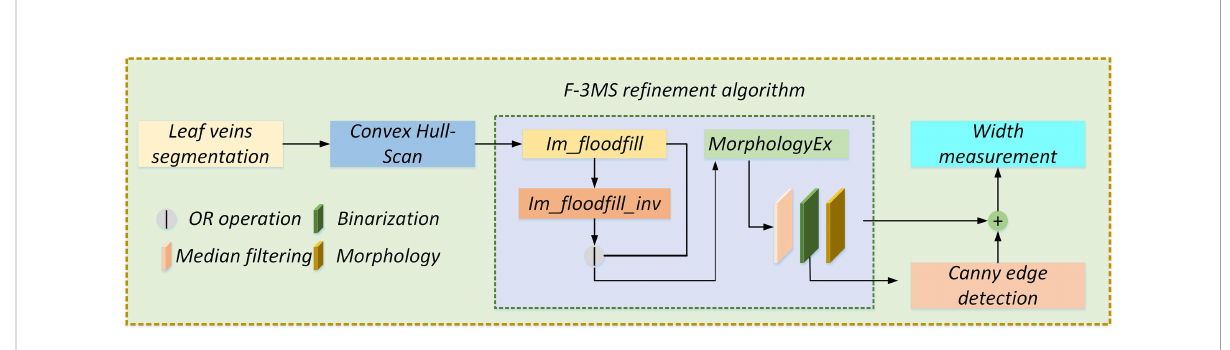
FIGURE 11 Width geometry model construction. Before measuring the leaf veins ’ width, the skeleton line of the complete leaf veins needs to be extracted by the F-3MS re fi nement algorithm. At the same time, the edge detection algorithm extracts the leaf veins ’ contour. Finally, by constructing a width geometric model and using the image bit operation, the width of the leaf veins is measured.